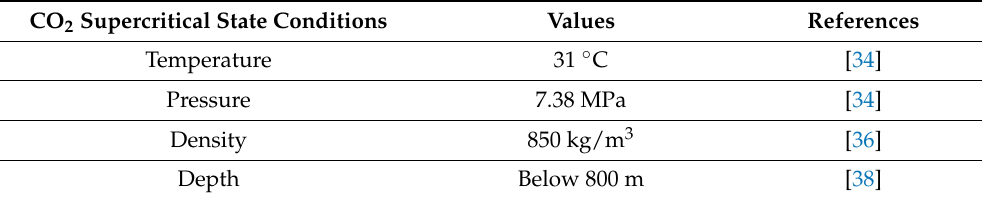
Table 3. CO 2 supercritical state conditions for injection and